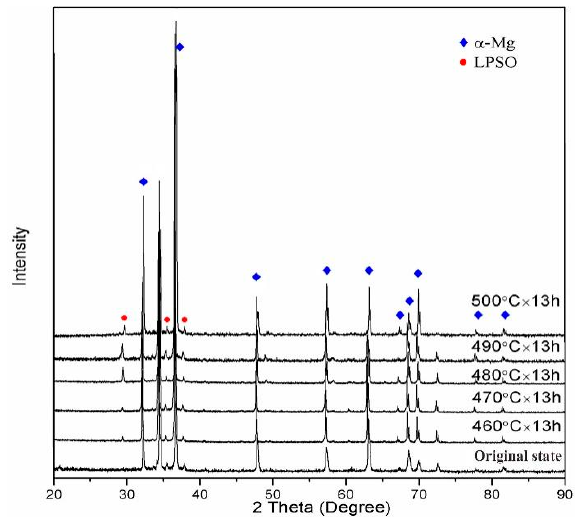
Figure 5. XRD of Mg alloy with a solution time of 13 h and different solution temperatures. To analyse the composition of the second phase in different forms, EDS was used to analyse the chemical composition of different areas of the Mg–9Gd–2Y–2Zn–0.5Zr alloy after solution treatment at 460 °C × 13 h and 490 °C × 13 h. The area was selected, and its EDS result is shown in Figure 6.